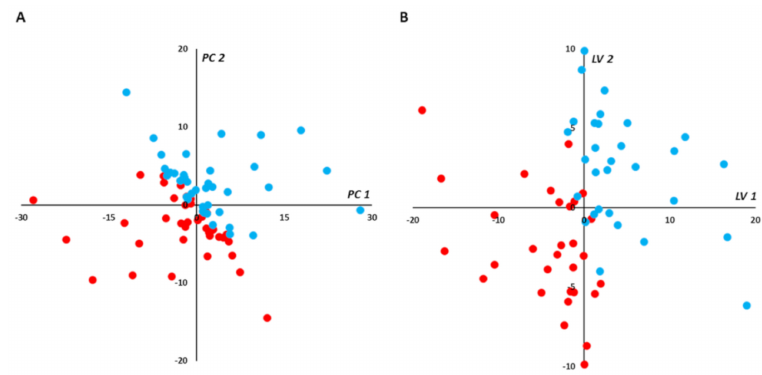
Figure 4. (red blood cells): Multivariate unsupervised ( A ) and supervised ( B ) scatter plots constructed with red cell samples. ( A ) Principal component analysis (PCA) scatter plot built with all samples ( n = 80; in-crisis (IC) / out-of-crisis (OC) = 40 / 40). Samples from IC patients (red circles) are roughly separated from samples taken from OC patients (blue circles) in the first principal plan of the PCA. No outlier was detected in this plan. ( B ) PLS-DA scatter plot built using median coordinates of best models and 60 samples (IC / OC = 30 / 30). A good separation was observed in the plan determined by two latent variables with only two samples misallocated. Legend : PC1,2: principal component 1 and 2, respectively. LV1,2: latent variable 1 and 2, respectively. Principal components and latent variables have no dimension (arbitrary units).